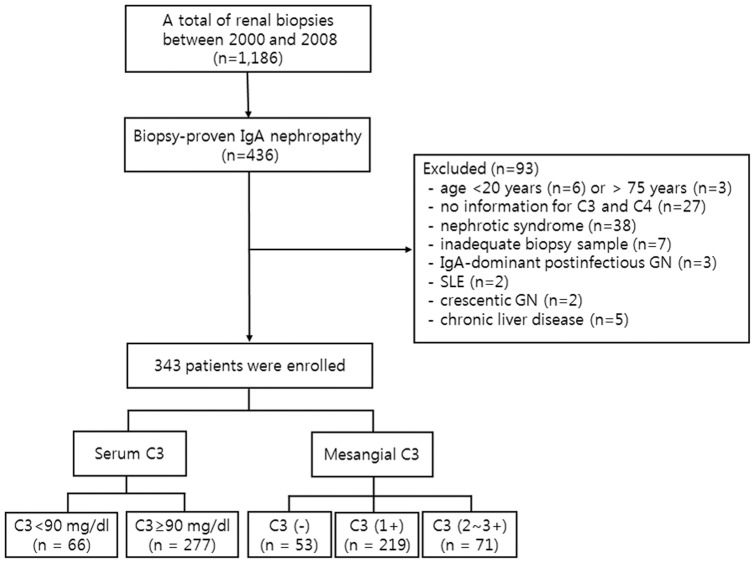
Flow diagram of the study.IgA nephropathy was diagnosed in 436 patients between January 2000 and December 2008. Excluding 93 patients, a total of 343 patients were enrolled. eGFR, estimated glomerular filtration rate; GN, glomerulonephritis; SLE, systemic lupus erythematosus.